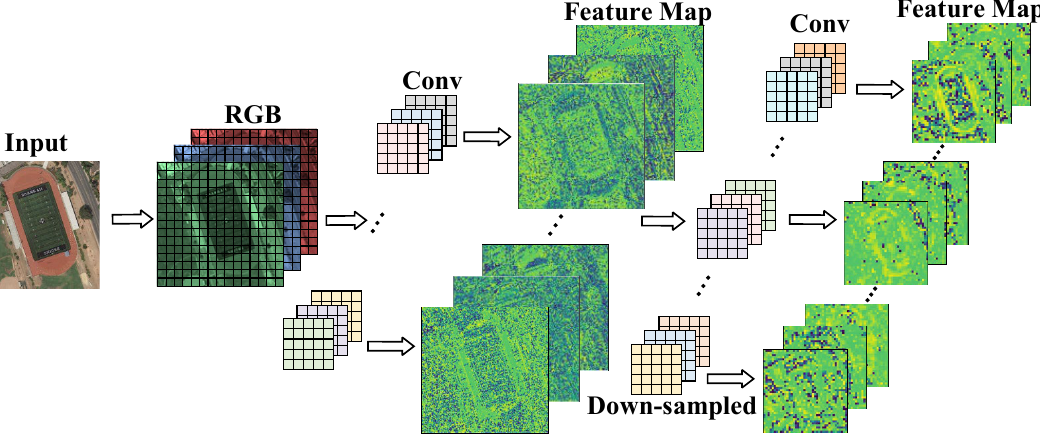
Figure 6. Downsampling of feature maps.